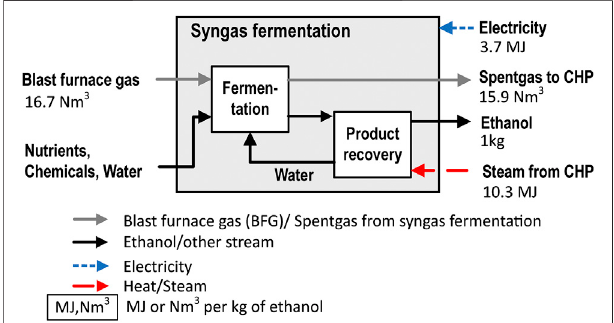
FIGURE 4 | Mass and energy balance of the syngas fermentation processusingtheBFGasthefeed.Theinputandoutputgas fl owsarevalidfor a steel mill con fi guration without CO 2 capture from the BFG upstream of the syngas